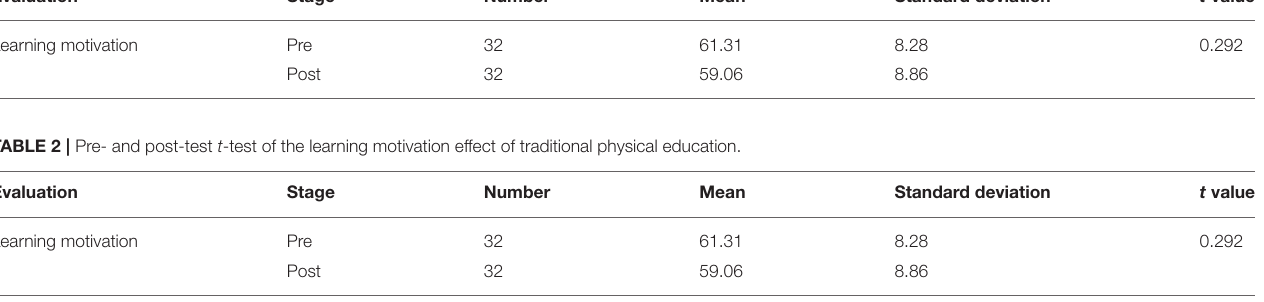
TABLE 1 | Pre- and post-test t -tests of the learning motivation effect of the exercise education model. Evaluation